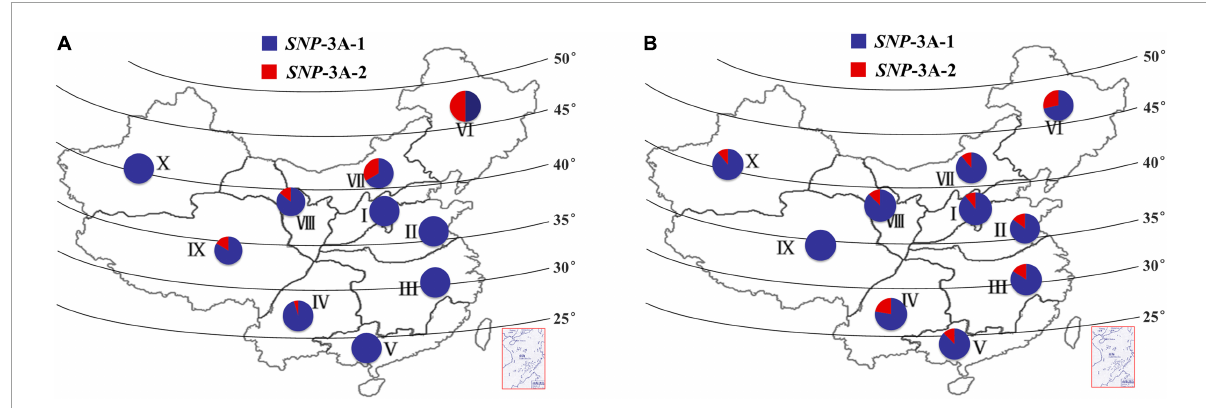
FIGURE5 Frequency and distribution of two TaMYB5-3A genotypes, SNP -3A-1 and SNP -3A-2. Distribution of two TaMYB5-3A genotypes from 157 landraces (A) and 348 modern cultivars (B) in 10 Chinese wheat production zones. I, Northern Winter Wheat Zone; II, Yellow and Huai River Valleys Facultative Wheat Zone; III, Middle and Low Yangtze Valleys Autumn-Sown Spring Wheat Zone; IV, Southwestern Autumn-Sown Spring Wheat Zone; V, Southern Autumn-Sown Spring Wheat Zone; VI, Northeastern Spring Wheat Zone; VII, Northern Spring Wheat Zone; VIII, Northwestern Spring Wheat Zone; IX, Qinghai-Tibetan Plateau Spring-Winter Wheat Zone; X, Xinjiang Winter-Spring Wheat Zone.